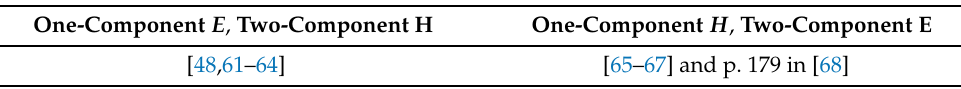
Table 1. Definitions of the TE mode differ. Table adapted by permission from Springer Table 8.1 in [1]